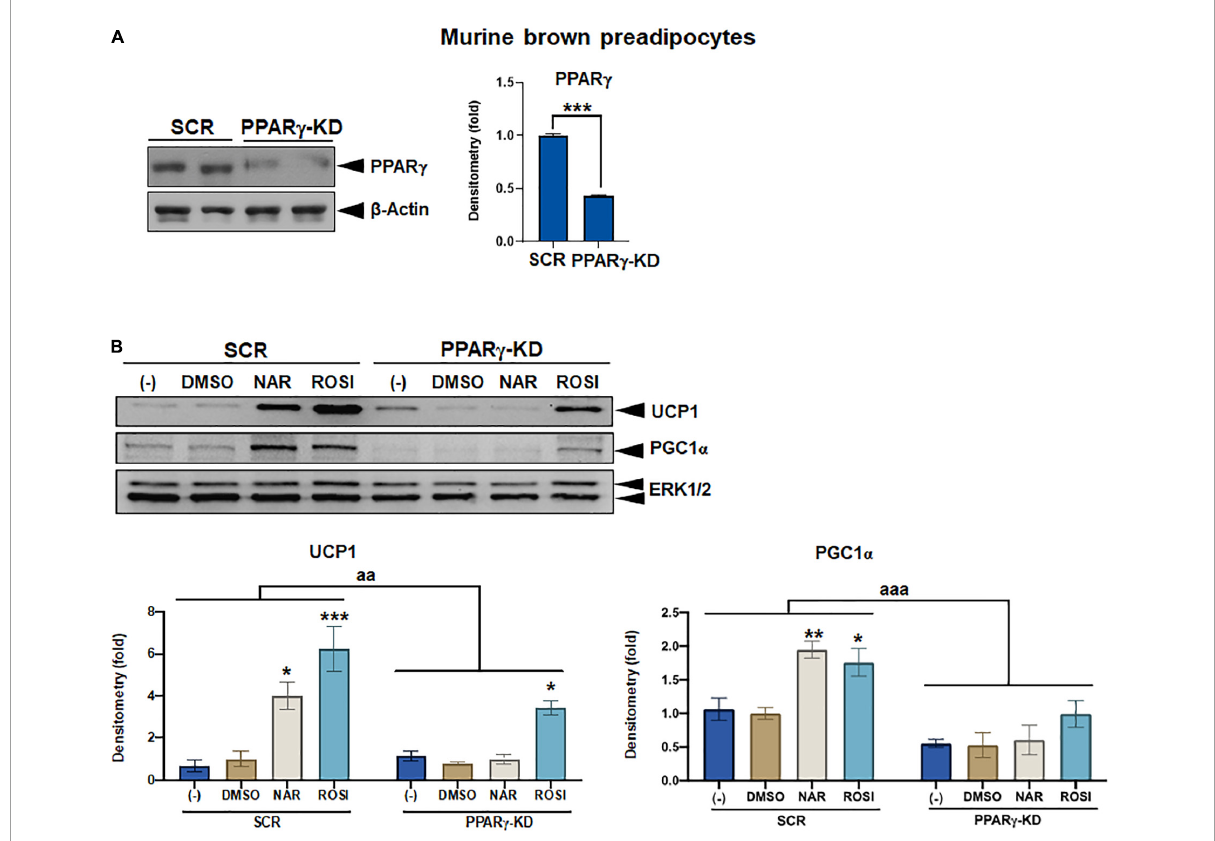
FIGURE7 Attenuation of thermogenic protein expression by peroxisome proliferator-activated receptor gamma (PPAR γ ) knockdown in naringenin-treated murine brown adipocytes. (A) Knockdown efficiency in murine brown pre-adipocytes with PPAR γ knockdown (PPAR γ -KD) compared to the cells with a scrambled non-targeting control (SCR). Two individual clones were analyzed. Average knockdown efficiency is shown. (B) PPAR γ -KD and SCR cells were differentiated in the presence or absence of NAR (10 µ M) or ROSI (1 µ M) for 6 days. Protein expression of thermogenic markers UCP1, PGC1 α , and the loading control ERK1/2 are shown. Bar graphs show the densitometry of each protein normalized to the loading control ERK1/2. Data = Mean ± SEM ( n = 3). *, **, *** p < 0.05, p < 0.01, and p < 0.001 compared to the SCR clones (A) or the DMSO samples within SCR or PPAR γ -KD group (B) , respectively. aa and aaa, p < 0.01 and p < 0.001 compared to the SCR group, respectively, by two-way ANOVA (B)